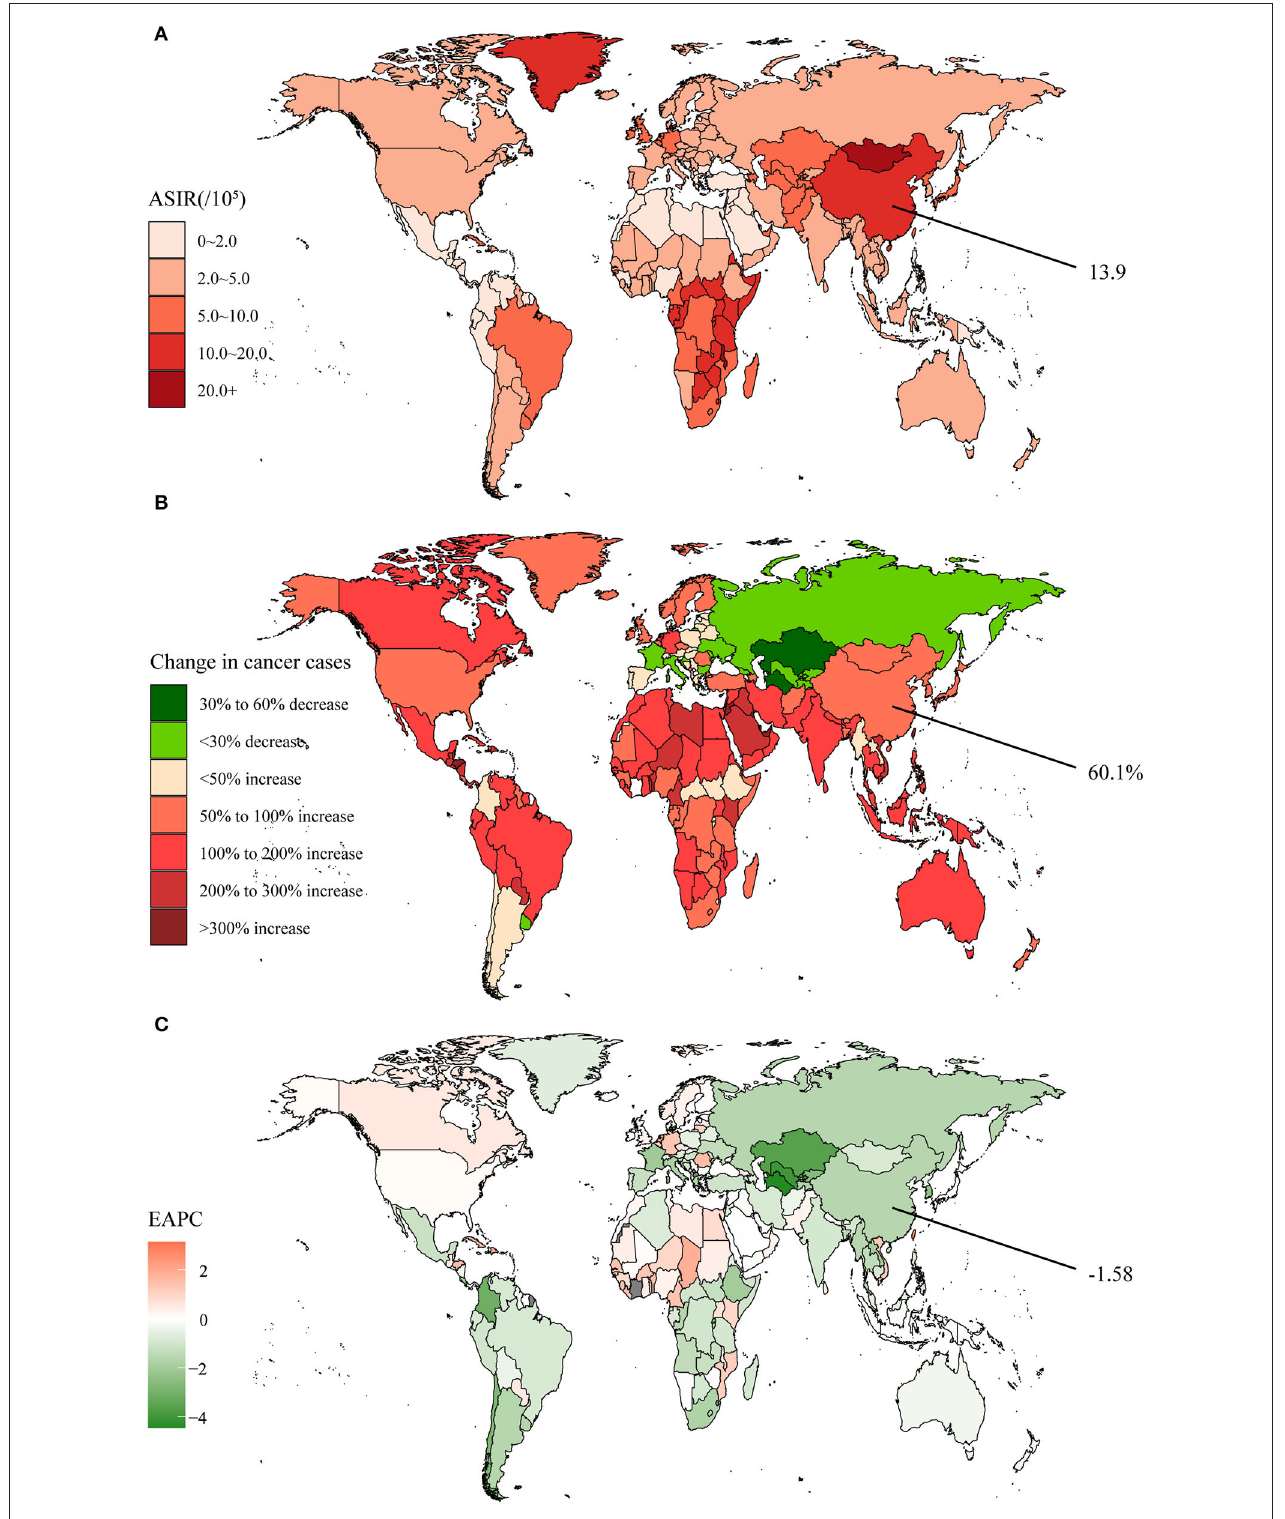
FIGURE 1 | The global disease burden of esophageal cancer in 204 countries and territories. (A) The ASIR in 2019; (B) The relative change in incident cases between 1990 and 2019; (C) The EAPC of ASIR from 1990 to 2019. Outcomes of China were specifically annotated. ASIR, age-standardized incidence rate; EAPC, estimated annual percentage